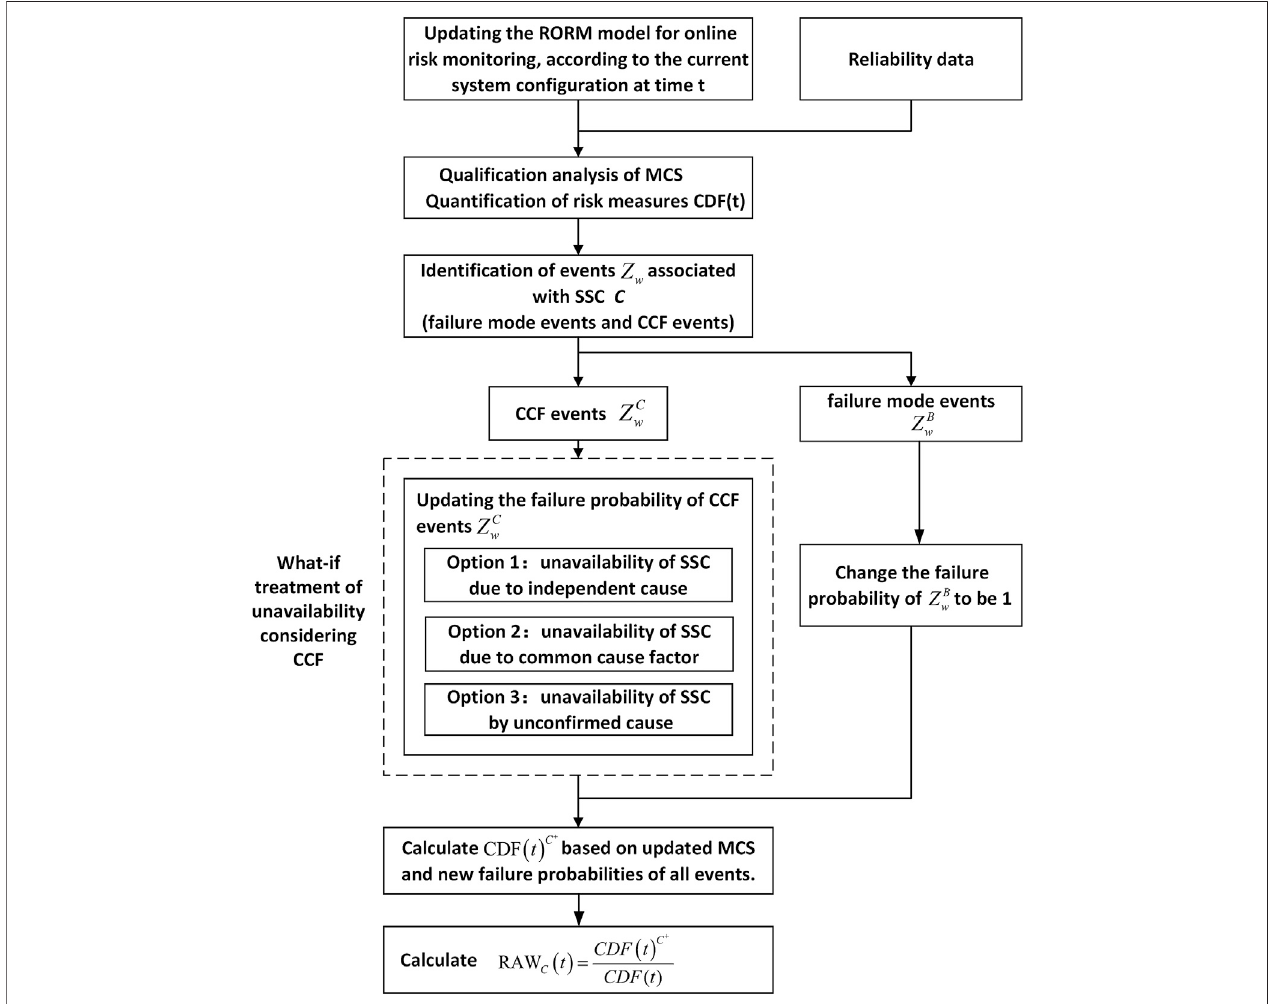
FIGURE 3 | Procedures of the RAW importance calculation of SSC C